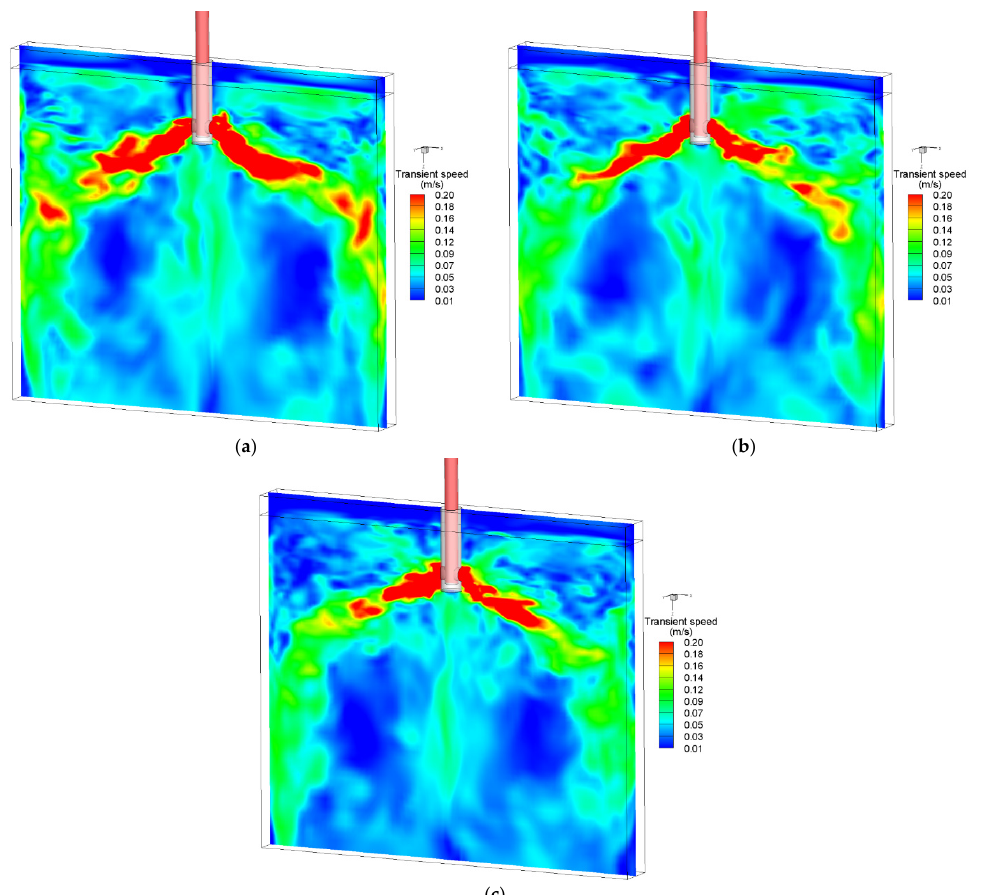
Figure 4. Distribution of the transient velocity at three different time shots: ( a ) t = 40.0 s; ( b ) t = 45.0 s; ( c ) t = 50.0 s.